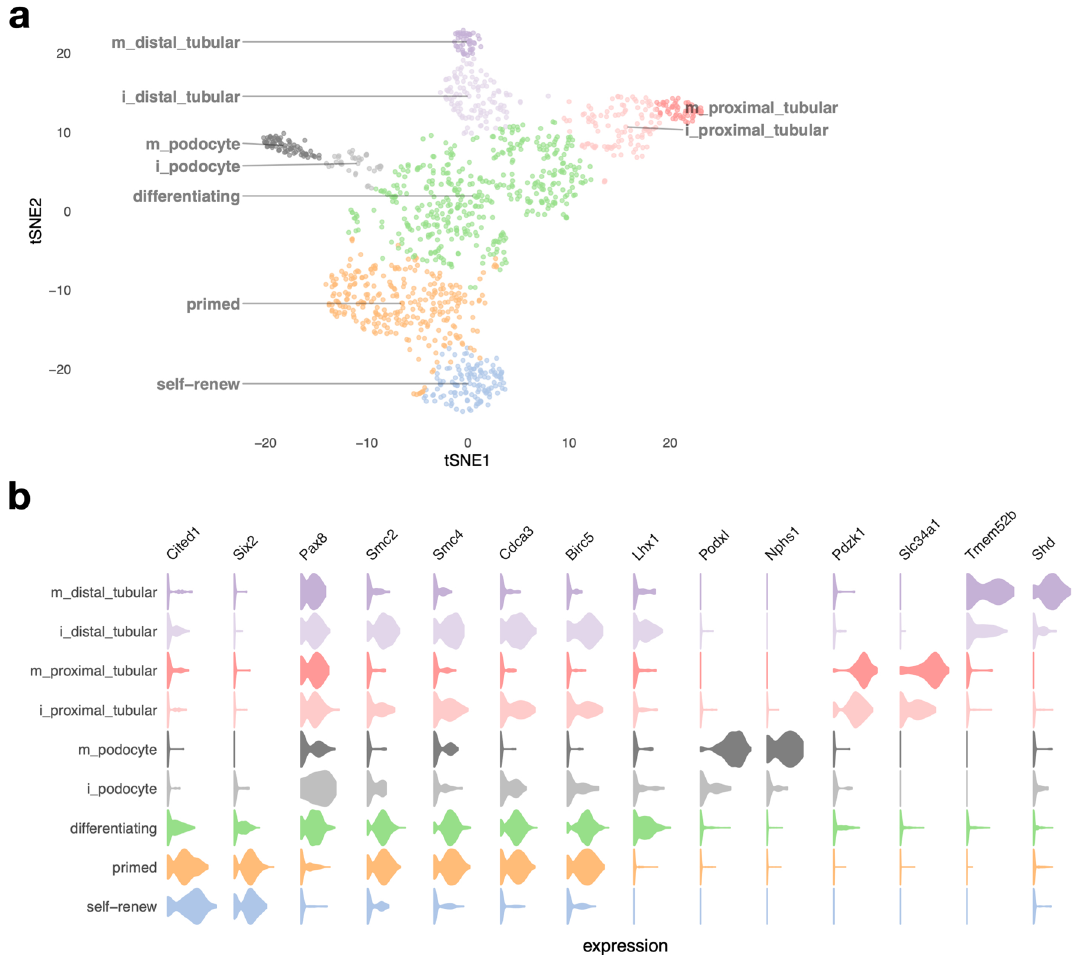
Figure 2. Cell types of the nephron progenitor lineage. (a) shows a tSNE plot of NP-derived cells, with clusters corresponding to cell types indicated by colors. The prefix “i_” indicates immature cells, while “m_” indicates mature cells. (b) shows violin plots of gene expression for known lineage-associated genes (columns), stratified by cluster (rows). We observe two types of NP cells (“self-renewing” and “primed”) and clear separation of distal and proximal tubular cells and podocytes in our